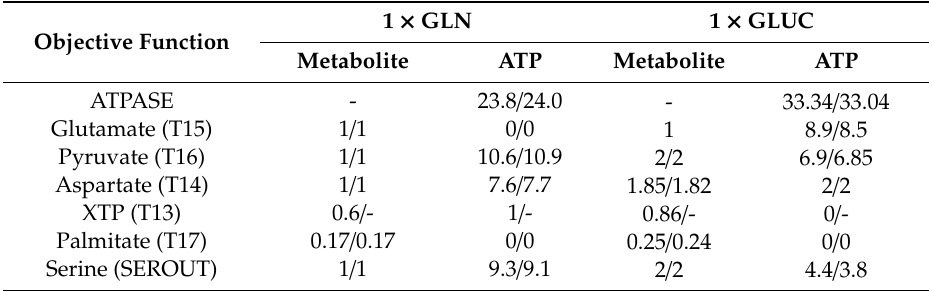
Table 1. The maximal yield in metabolites synthesis or energy (ATP) from glutamine and glucose at steady state. The first value is obtained with C2M2N and the second with